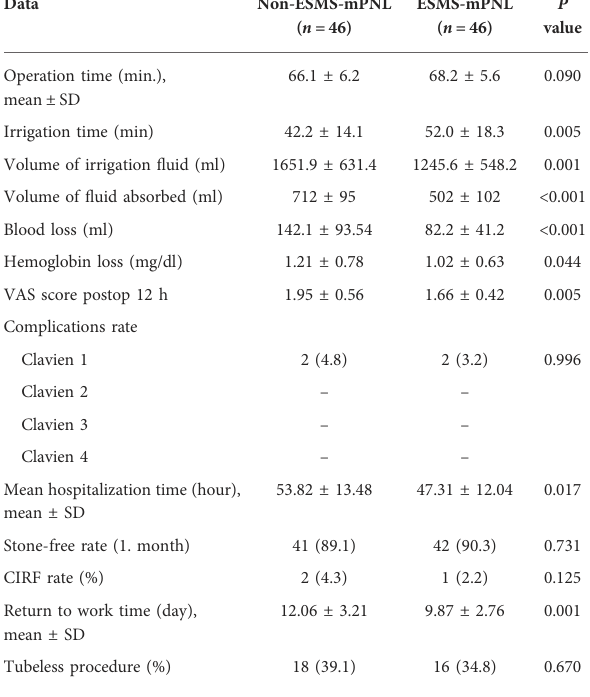
TABLE 4 Comparison of operative data and complications for Non- ESMS-mPNL vs ESMS-mPNL groups.